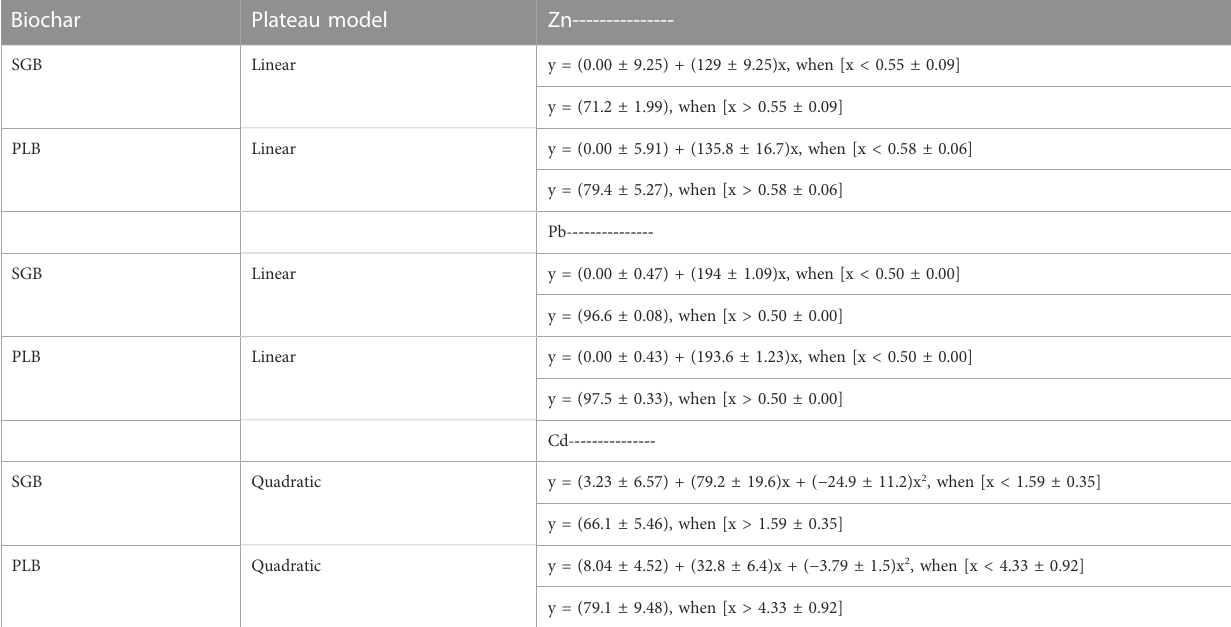
TABLE 2 Equations from the linear- and quadratic-with-upper-plateau statistical models to predict uptake reduction (%) of heavy metals by ryegrass shoots. Biochar